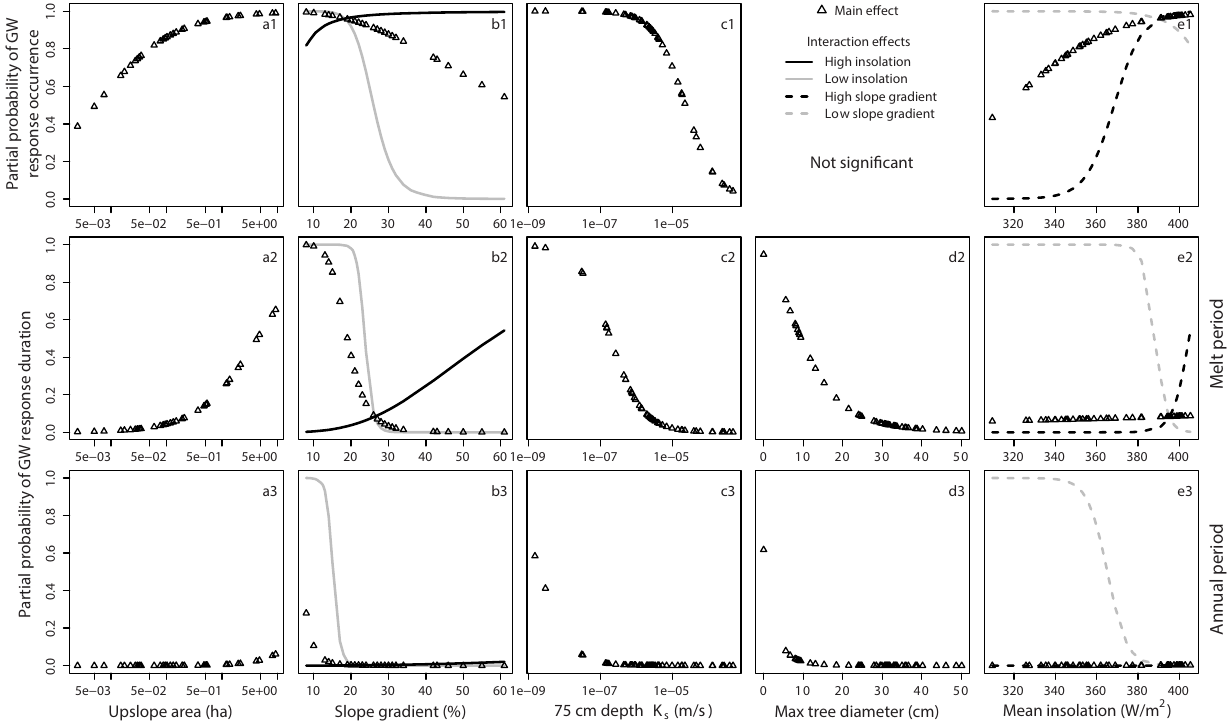
Figure 4. Partial probability of groundwater response for predictor variables in the logistic regression models. Streamflow periods are indicated on the far right side of the rows. The response variable for the top row is the occurrence of a groundwater response. The response variable for the middle and lower rows is the duration of groundwater response. For calculating partial probabilities, all other predictor variables were held at their respective mean (geometric mean for K s ) values, except interaction variables, which were held at their respective minimum or maximum values. The timing of each period is indicated Sect. 2.3.3 and Fig.